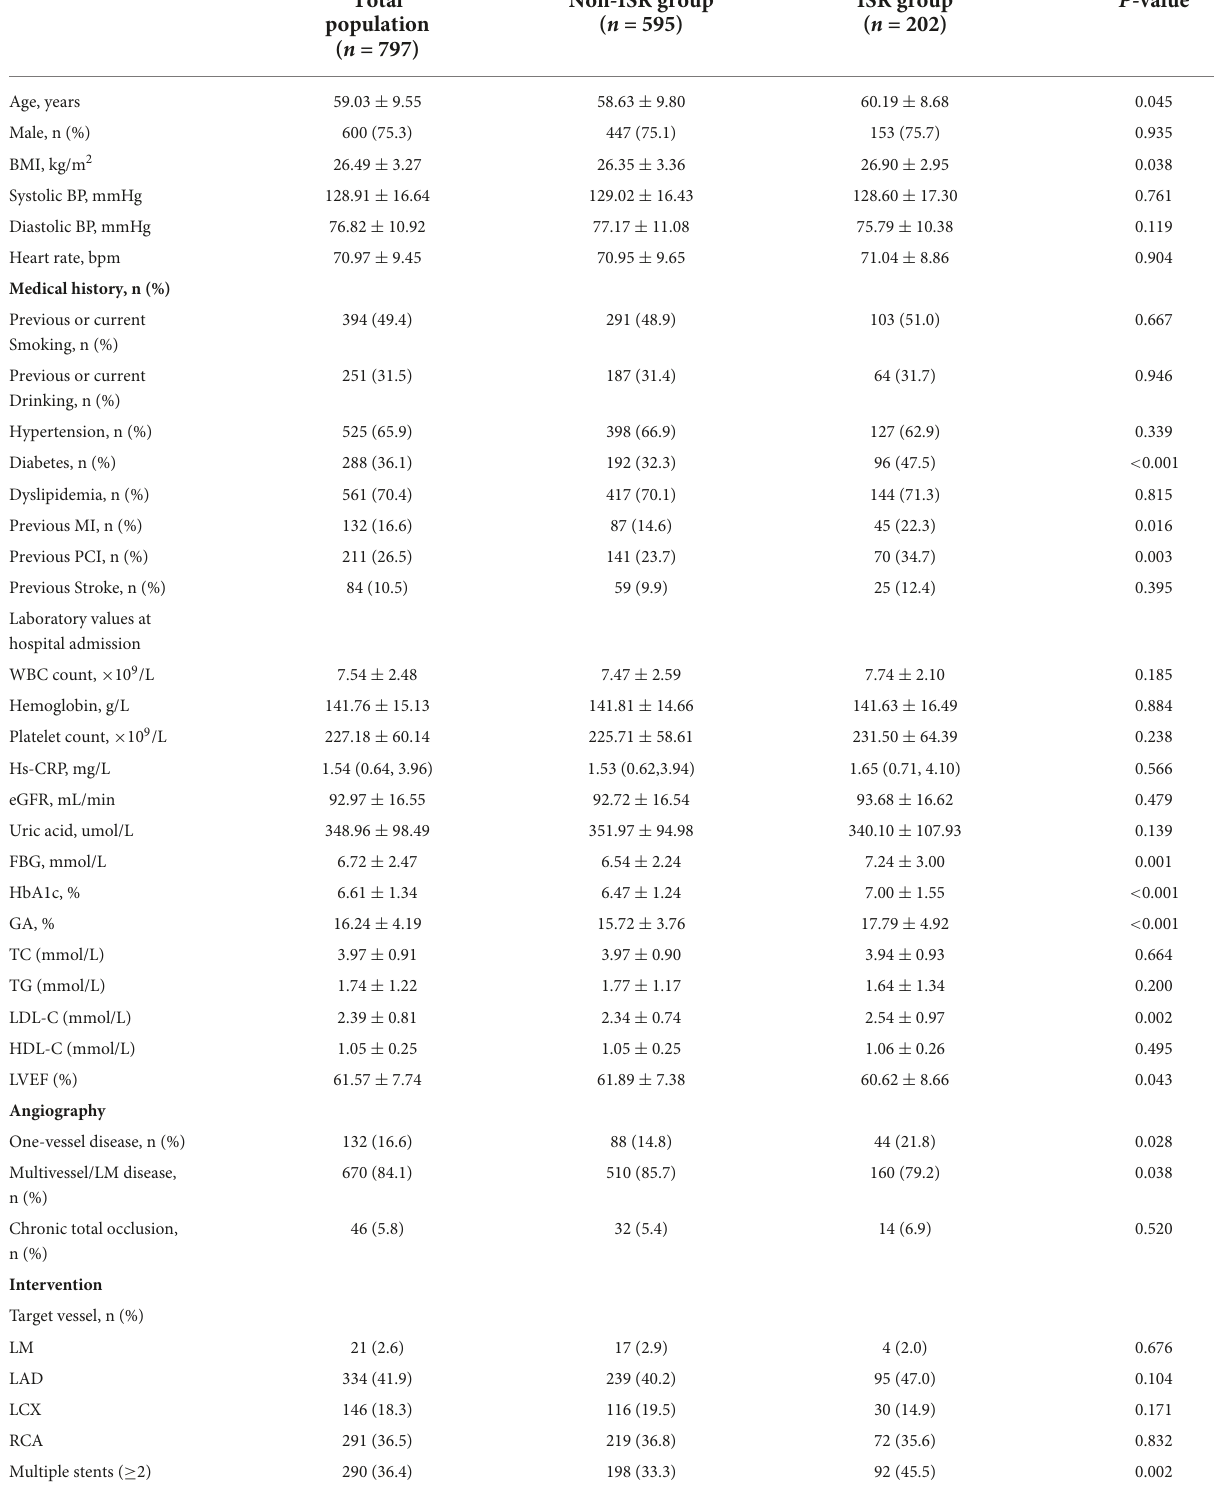
TABLE 2 Baseline characteristics of patients with and without